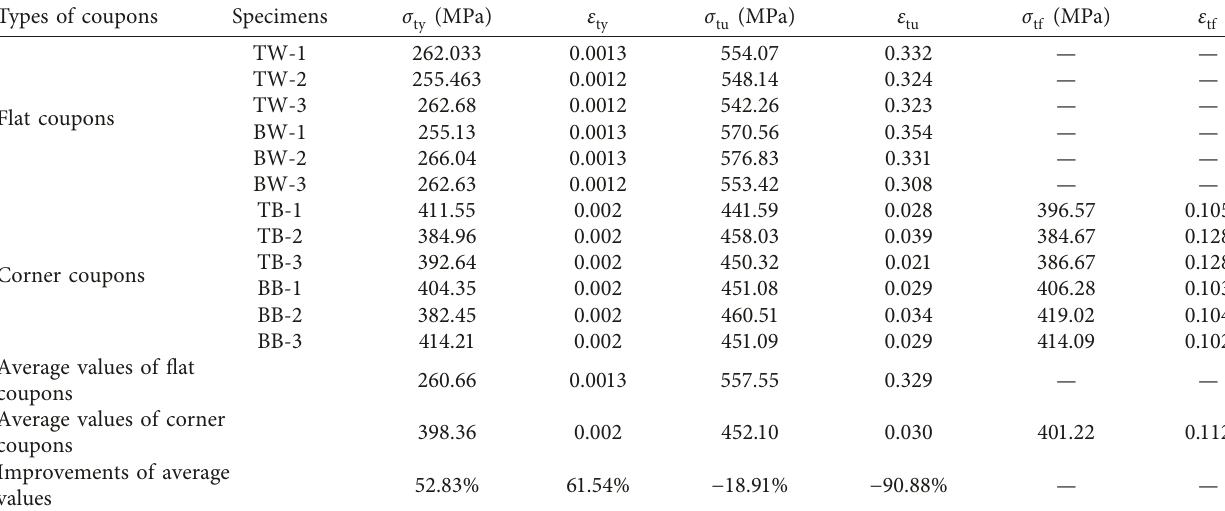
Table 4: Mechanical parameters of true stress-strain